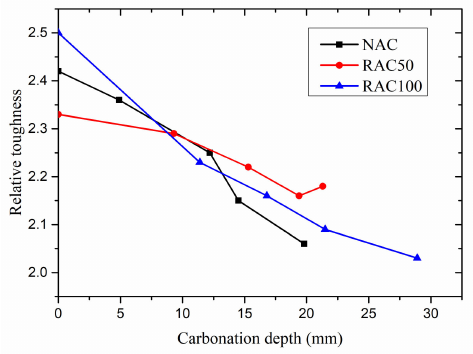
Figure 12. Relative toughness versus carbonation